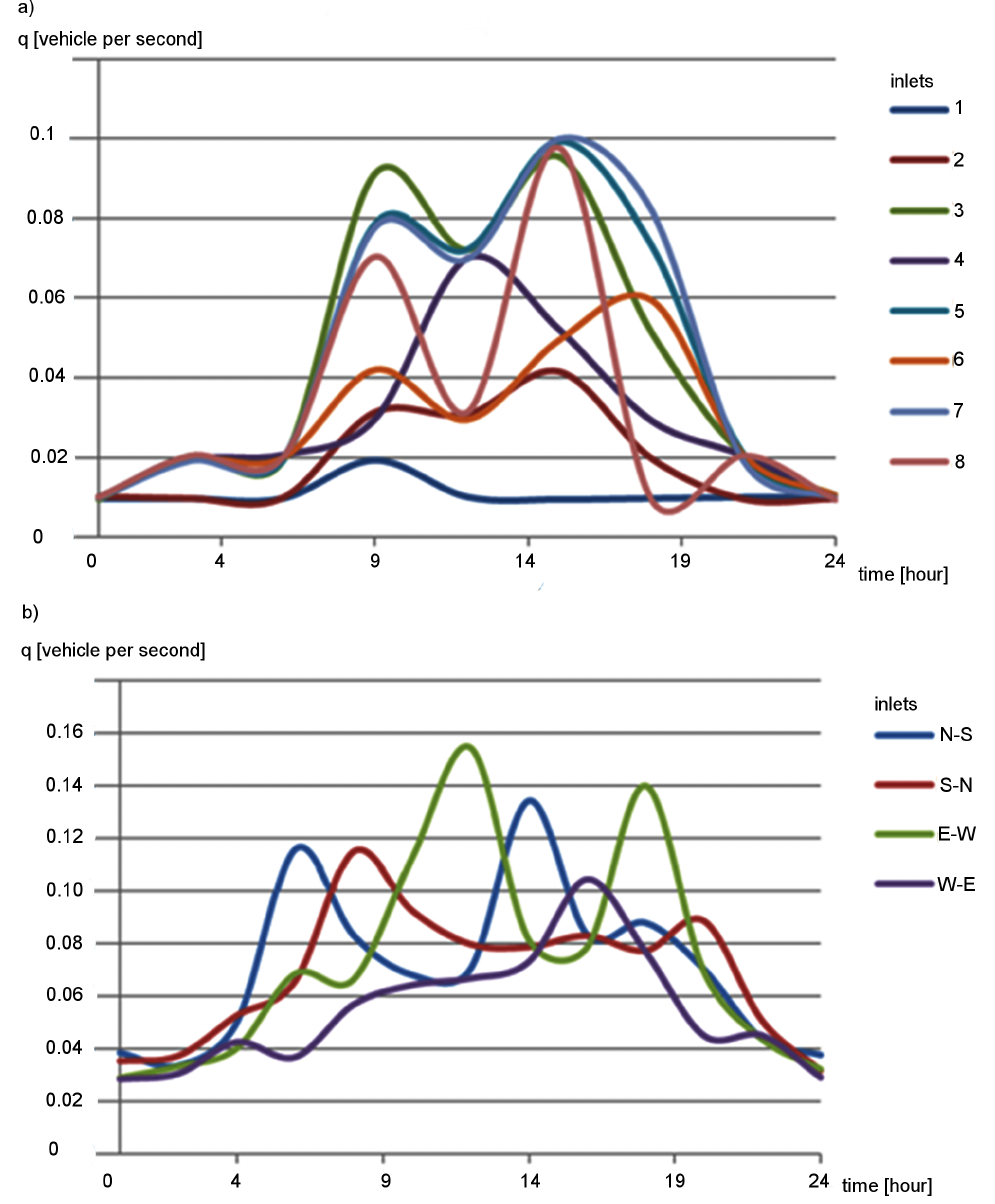
Figure 10. Profiles of traffic intensity (q): ( a ) arterial road scenario; and ( b ) grid road network